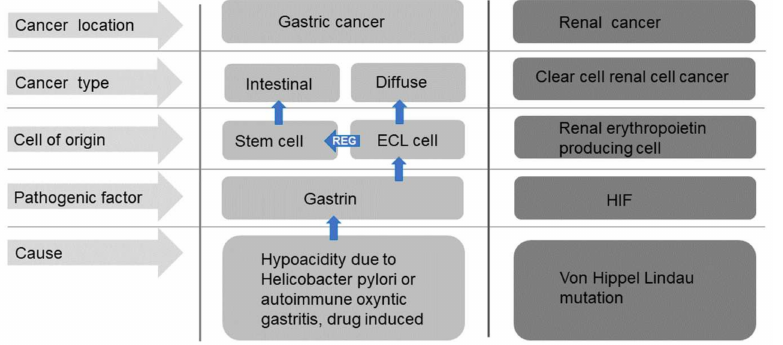
Figure 4. Schematic overview of the cells of origin and pathogenesis of the most important gastric and renal